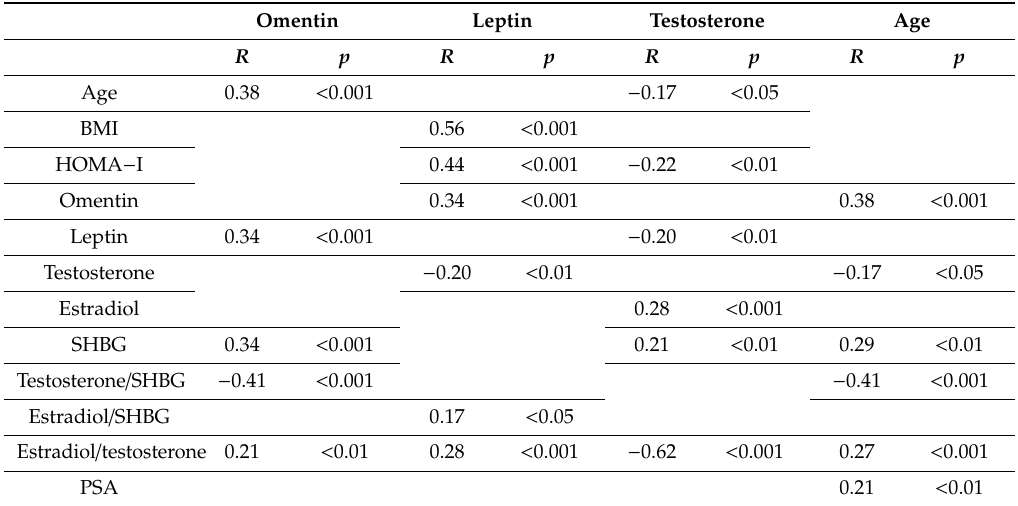
Table 3. Spearman’s coe ffi cients of the relationships among analyzed variables in all subjects.